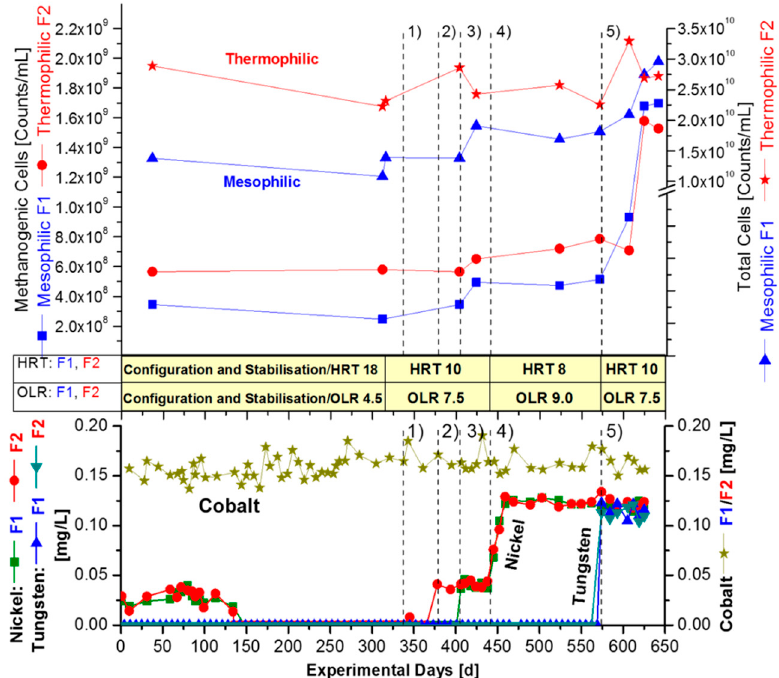
Figure 2. Successive addition of nickel in mesophilic and thermophilic CSTR fermenters, with wheat straw as the sole substrate in ‘synthetic manure’. Dissolved ions in fermenter F1 (mesophilic) and F2 (thermophilic). Targeted concentrations of supplemented and monitored ions of nickel and tungsten were: Period 1 (340–370 d) + 0.05 mg/L Ni in F2. Period 2 (370–405 d) + 0.05 mg/L Ni in F2. Period 3 (405–440 d) + 0.05 mg/L Ni in F1, F2. Period 4 (440–570 d) + 0.15 mg/L Ni + EDTA in F1/F2. Period 5 (570–640 d) + 0.15 mg/L Tungsten in F1/F2 (without EDTA). Dissolved ion concentrations of cobalt, nickel, and tungsten, as analysed with TXRF. A pre-fermentation period of about 140 days, with an HRT of 18 days and OLR of 4.5 gVS/L/d was performed ahead (not shown here) to enable technical modifications.